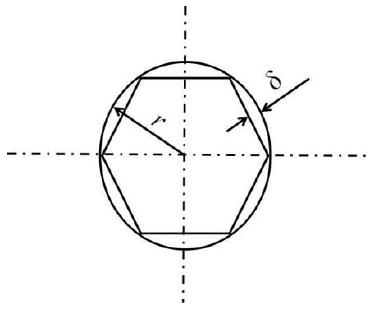
Figure 6. Diagram of honeycomb.